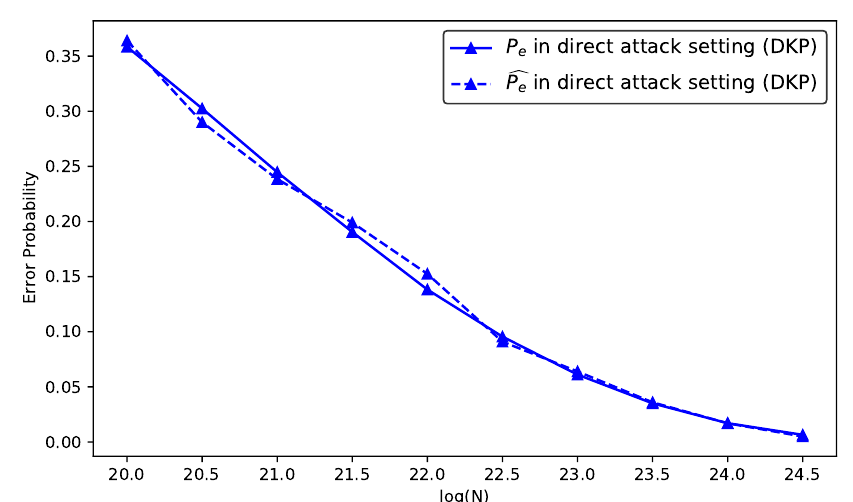
Figure 6: Comparison of error probabilities using the direct attack models under DKP sampling using the MLE-based models described in Sect.